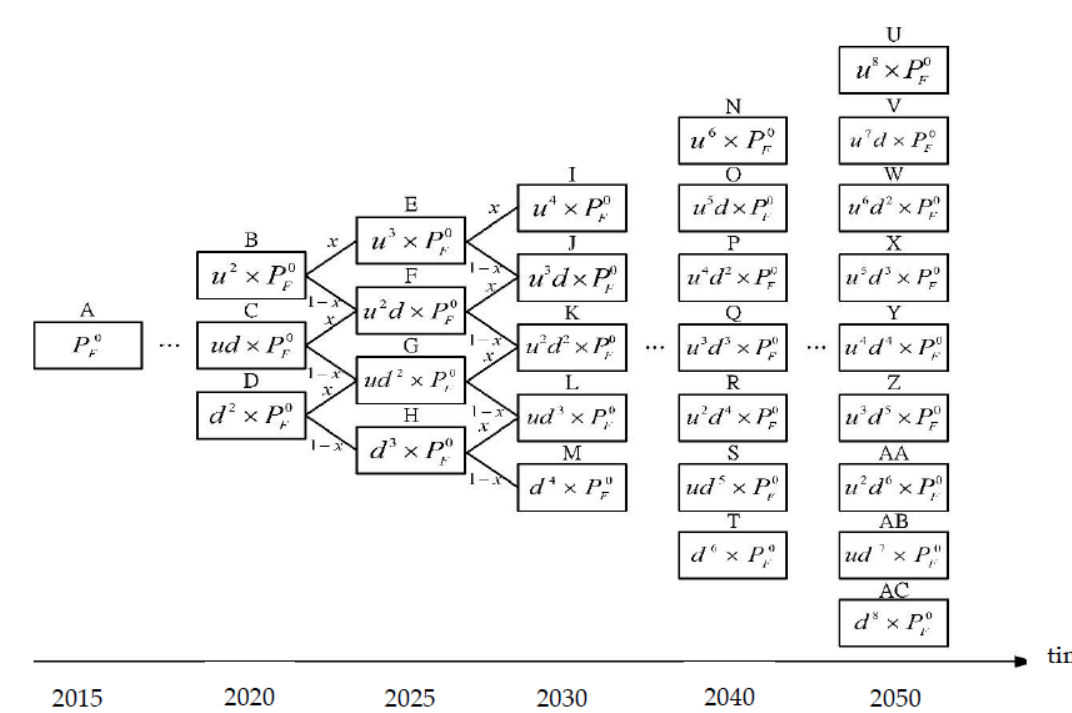
Figure 1. The long-term unit cost of power generation estimation. (US$/KWh). Source: This research.